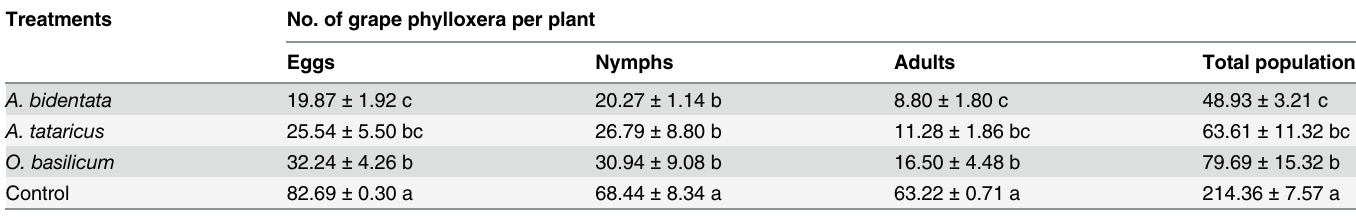
Table 4. The effects of Chinese medicinal herbs to grape phylloxera in potted grapevine bioassay before its population established.